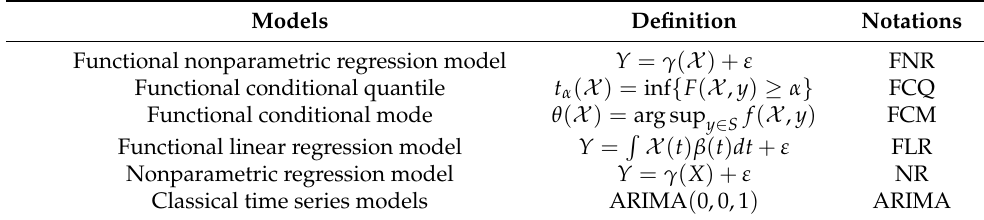
Table 3. The different prediction models.